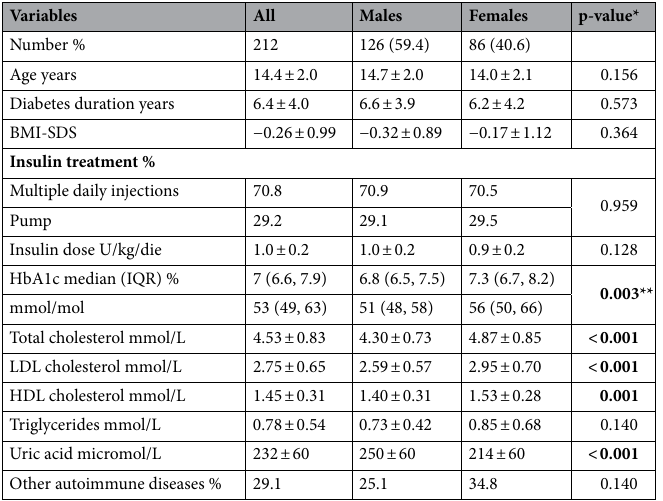
Table 1. Patients characteristics. Data are presented as mean and standard deviation unless otherwise specified. BMI-SDS body mass index-standard deviation score, HbA1c glycated hemoglobin, LDL low density lipoprotein, HDL high density lipoprotein. *Females vs males. For comparisons between groups two-tailed t-test was used. **Mann–Whitney test. Significant values are in